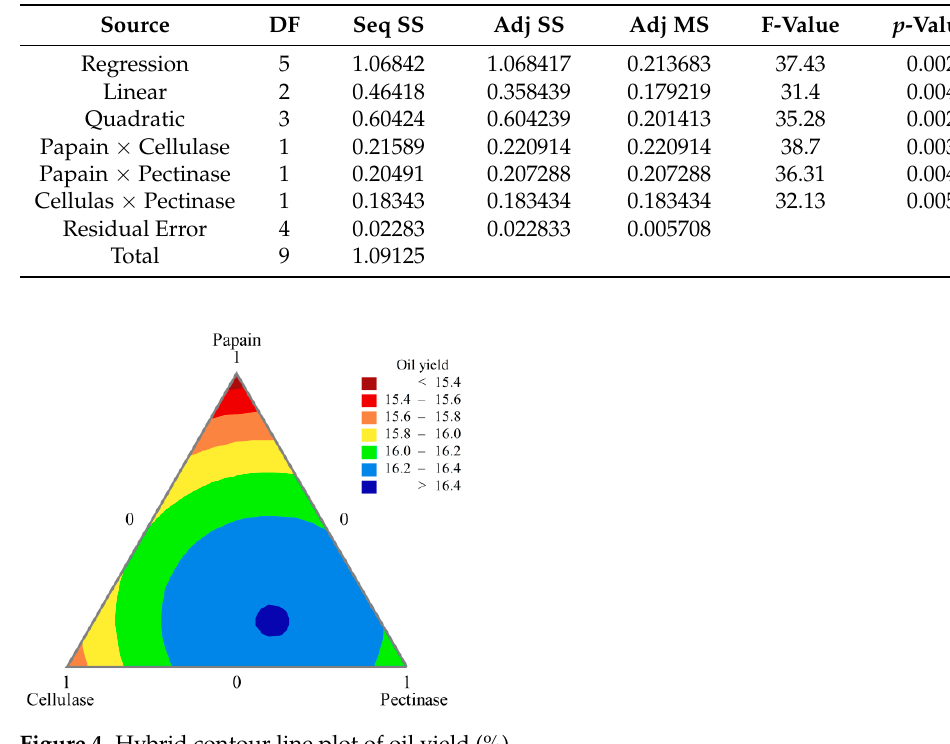
Table 5. ANOVA results of the enzyme mixture designs.